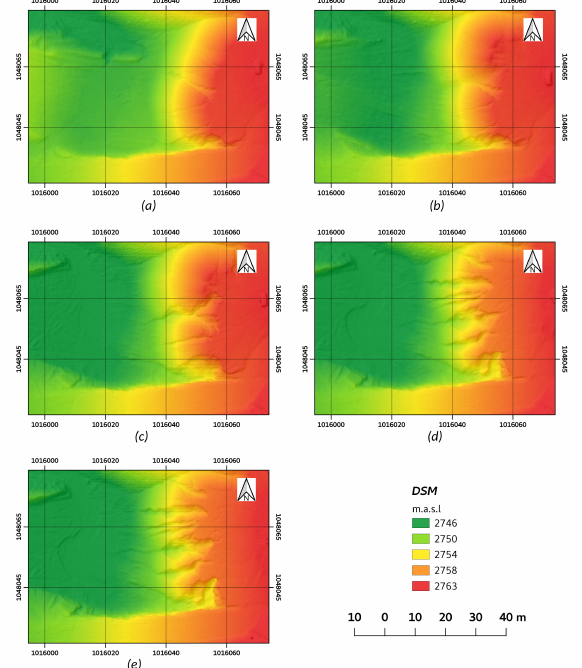
Figure 7. DEMs obtained for all months under study: (a) January; (b) February; (c) March; (d) April; and (e) May.